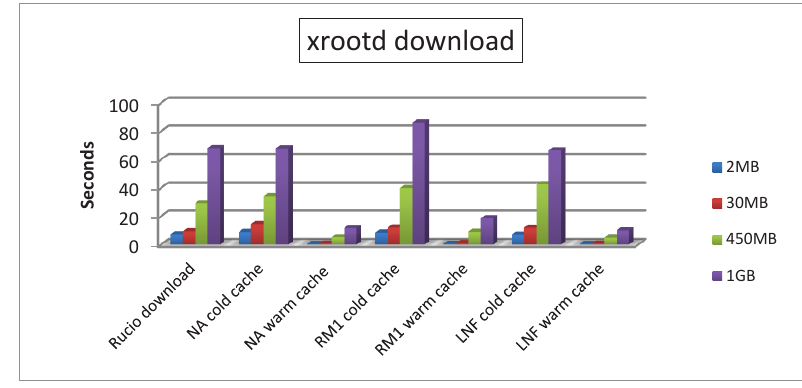
Fig. 4. Transfer time for files of different sizes (average values, statistical uncertainty